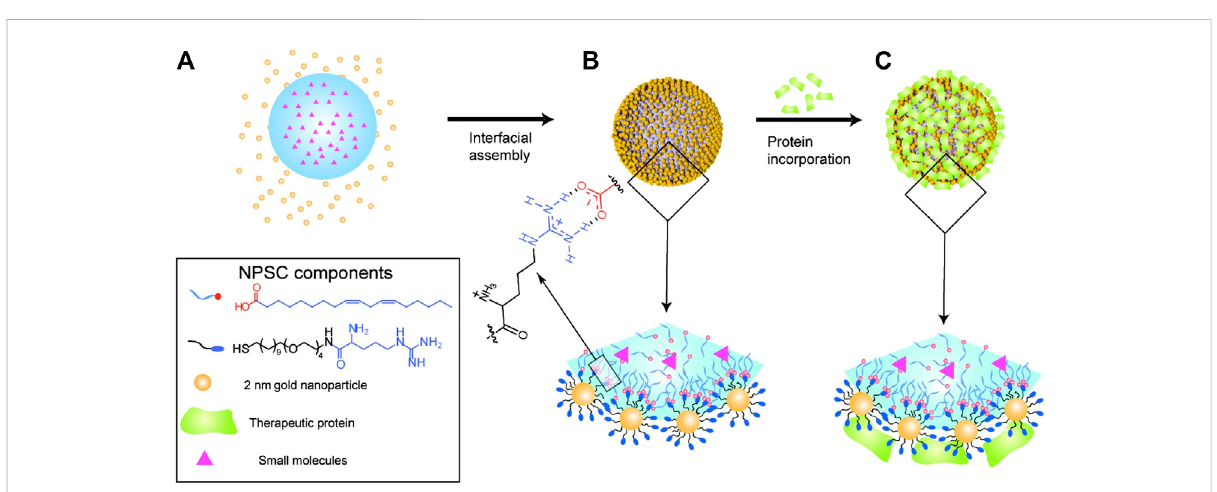
FIGURE 2 NPSC fabrication. (A) Template droplets (with or without PTX) were generated using an amalgamator. (B) Droplets were transferred to Arg- AuNP solution to generate NPSCs. (C) Incorporation ofCASP3 ortransferrin (control)ontotheNPSCsurface. Reproduced with permission fromRef. (Kim et al.,